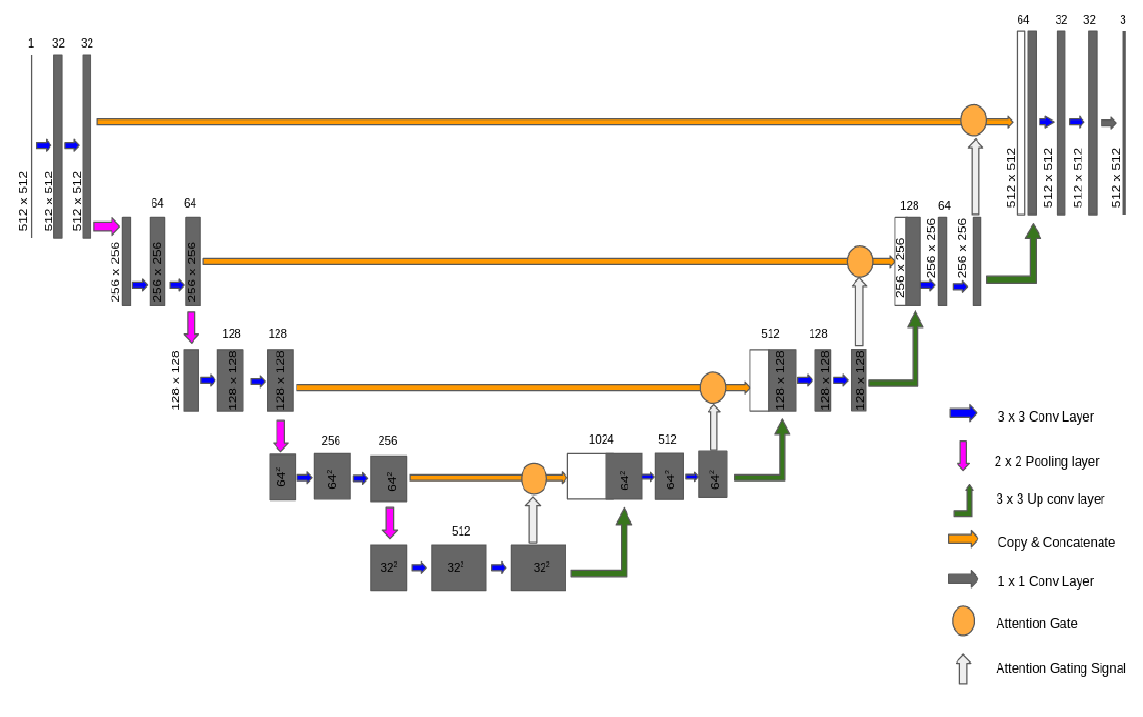
Figure 1. General overview of the proposed Attention